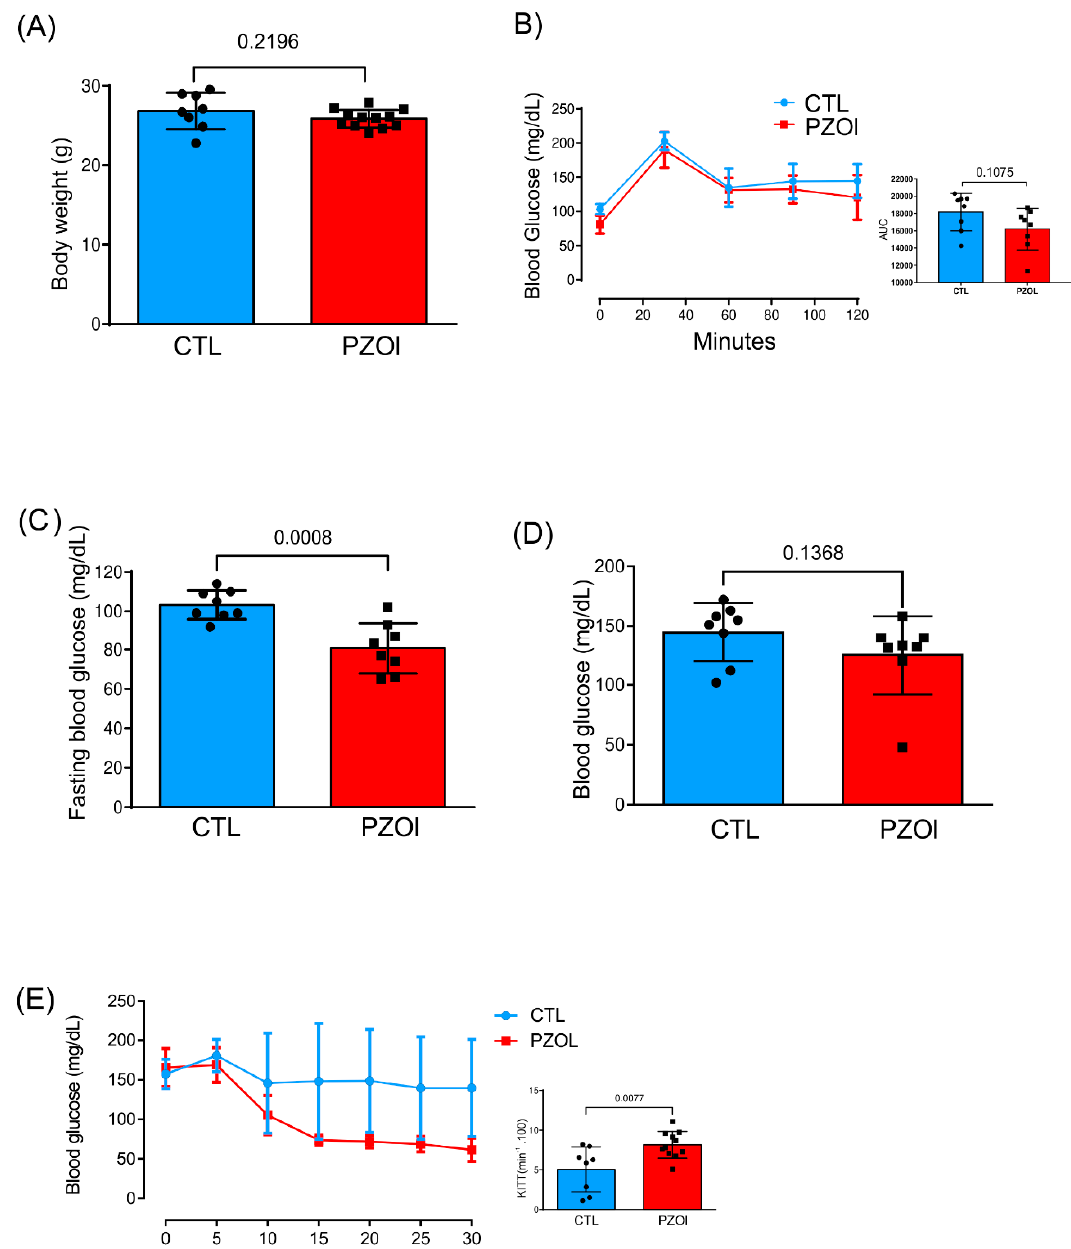
Figure 1. Effect of pantoprazole treatment. ( A ) Body weight (CTL: n = 8 and PZOL: n = 12); ( B ) GTT curve and AUC (CTL: n = 8 and PZOL: n = 8); ( C ) fasting blood glucose (CTL: n = 8 and PZOL: n = 8); ( D ) blood glucose 120 min after glucose injection (CTL: n = 8 and PZOL: n = 8); ( E ) kITT, from CTL and PZOL-treated mice (CTL: n = 8 and PZOL: n = 11). Data are expressed as mean ± standard deviation and t -test statistical comparisons.